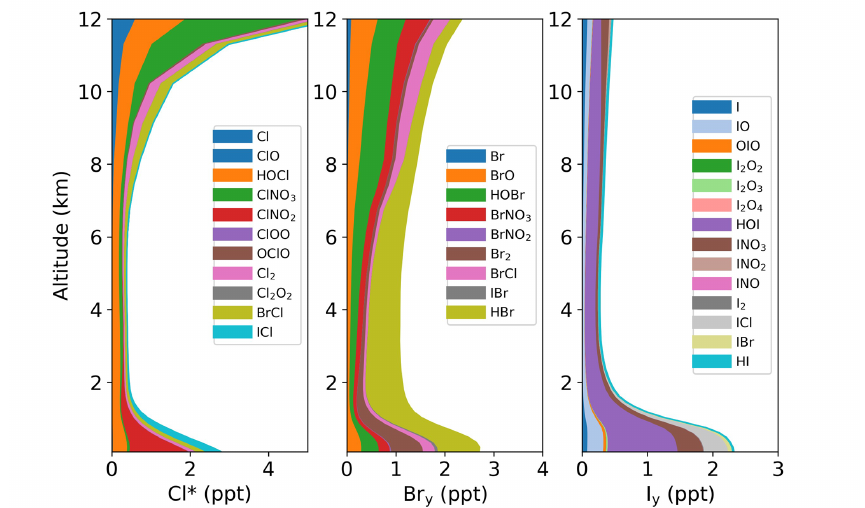
Figure 3. Global annual mean vertical speciation in GEOS-Chem of reactive chlorine (Cl ∗ ≡ Cl y − HCl), gaseous inorganic bromine (Br y ), and gaseous inorganic iodine (I y ;